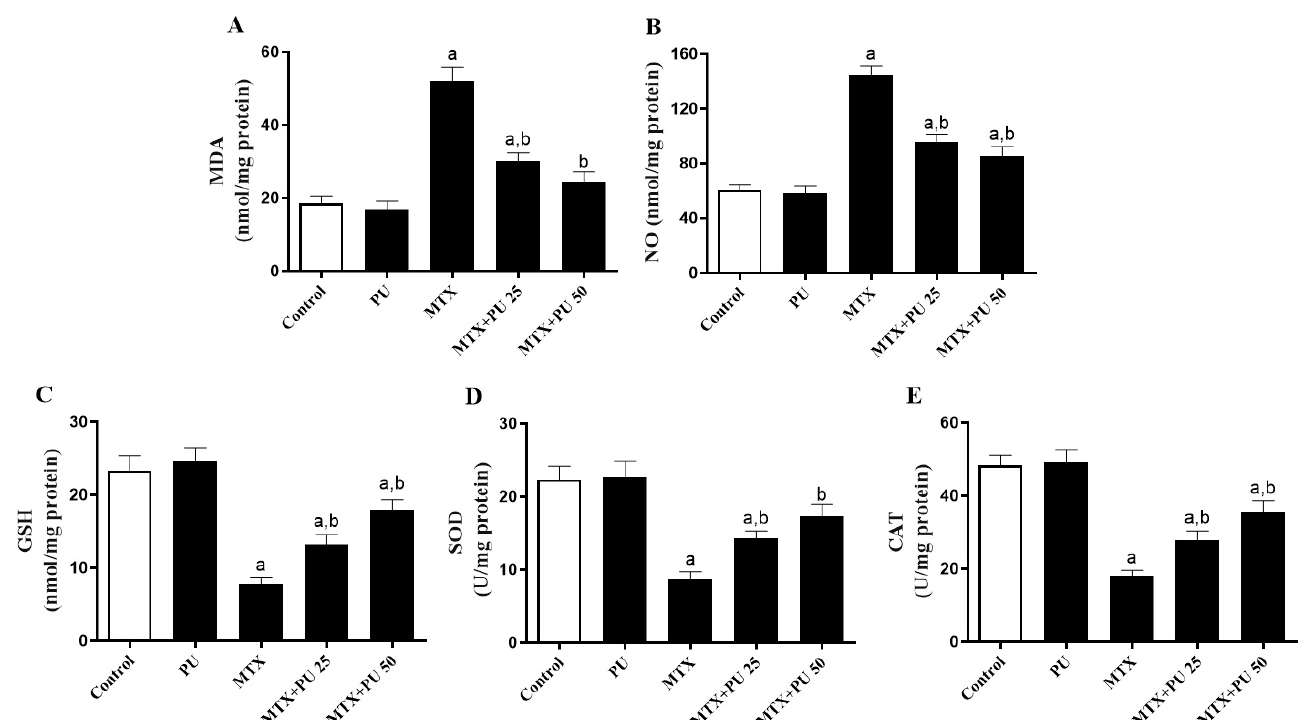
Figure 3. PU reduces hepatic levels of oxidative stress markers in mice exposed to MTX. Pre-treatment with PU decreased hepatic ( A ) MDA and ( B ) NO levels, elevated ( C ) GSH level, and ( D ) SOD and ( E ) CAT activities in MTX-injected mice. Results are expressed as mean ± SEM, ( n = 6). a indicates significant ( p < 0.05) vs. control, while b indicates significant ( p < 0.05) vs. MTX.